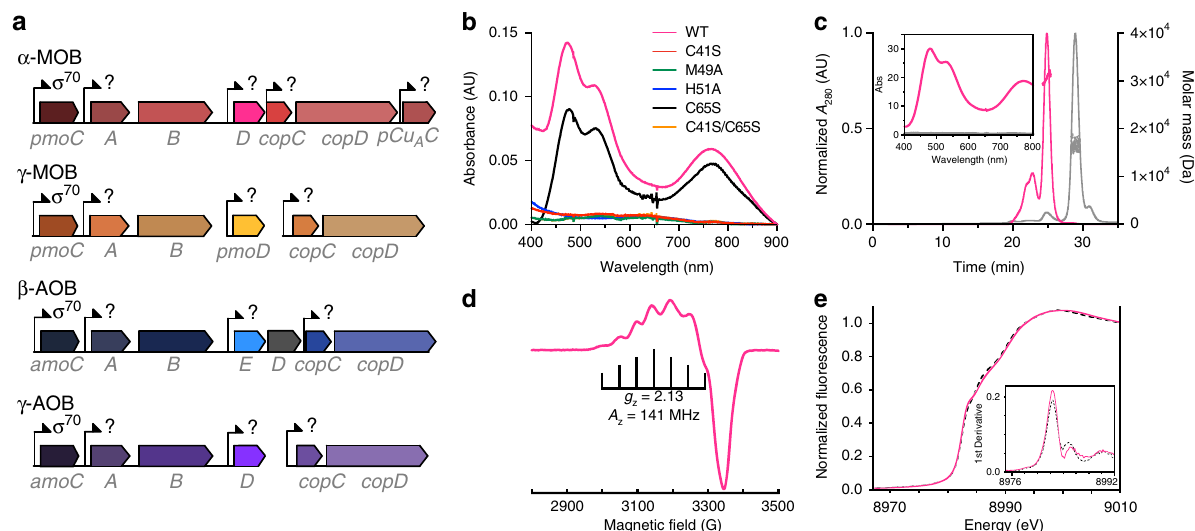
Fig. 1 PmoD Met49242_1452 forms a dimeric species containing a Cu A site. a Connections between pmo / amo , pmoD / amoD , amoE , copCD , and pCu A C genes in a range of AOB and MOB species. b Optical spectra of wild-type PmoD Met49242_1452 periplasmic domain (WT) and variants thereof (200 μ M protein). All samples were loaded with ~2 equivalents copper and desalted prior to data collection. c SEC-MALS pro fi les for the two species isolated by size exclusion chromatography. Inset shows optical spectra collected at the apex of the predominant peak. Pink traces indicate the Cu A species (molar mass 30,540 Da ± 2%) and gray traces indicate the monomeric species (molar mass 16,250 Da ± 3%). d CW X-band EPR spectra of Cu A PmoD Met49242_1452 ; g x = 2.01, g y = 2.05, g z = 2.13. Brackets de fi ne the Cu hyper fi ne splitting at g z ( A z ). Conditions: 9.364 GHz microwave frequency, 16 G modulation amplitude, 160 ms time constant, 90 s per scan, temperature 20 K. e Cu XANES spectra for wild-type (solid line) and C65S (dashed line) PmoD Met49242_1452 . Inset shows the fi rst derivatives of both XANES spectra identifying features at 8983.2 and 8987.8 eV ( fi rst in fl ection energies at 8982.5 and 8985.3 eV) typical for mixed valent Cu( + 1.5) – Cu( + 1.5)